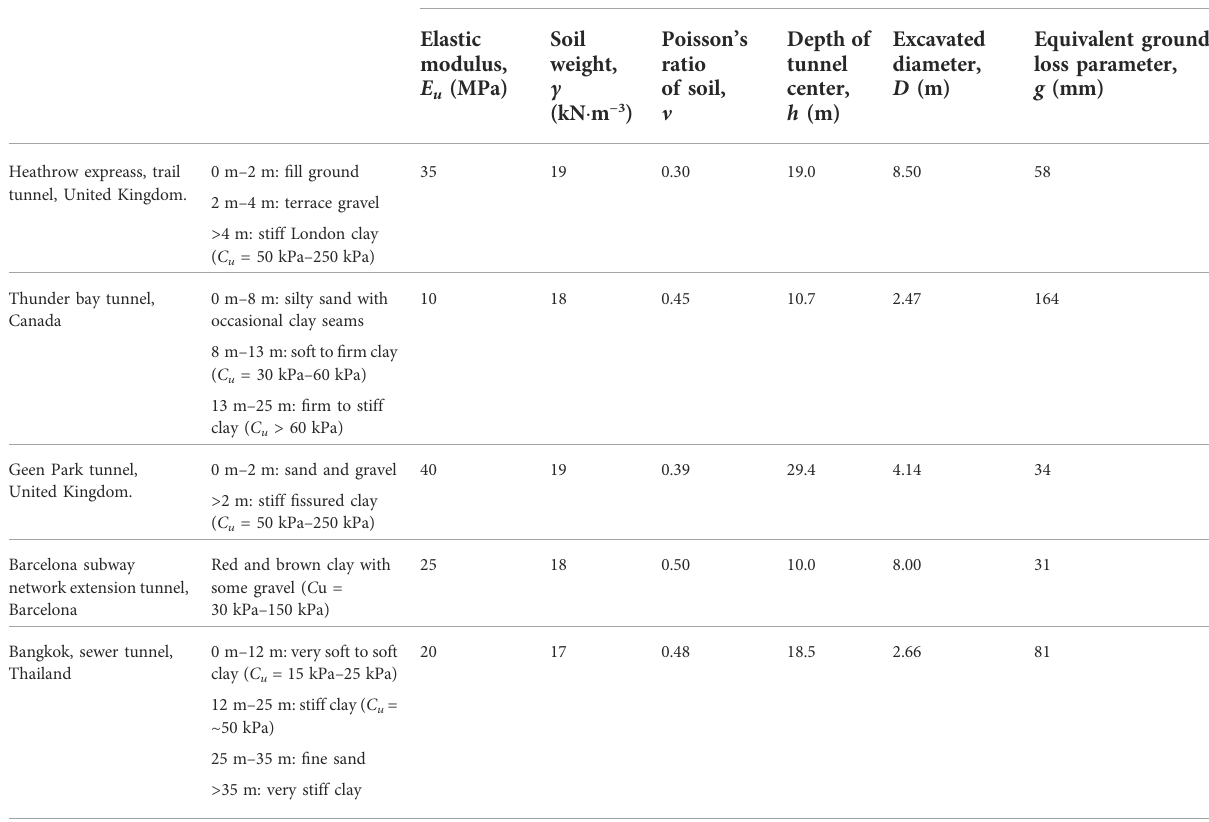
TABLE 2 Soil layers and relevant calculation parameters of circular tunneling-induced soil deformation (Loganathan and Poulos, 1998). Tunnel Soil layers Relevant calculation parameters of soil deformation